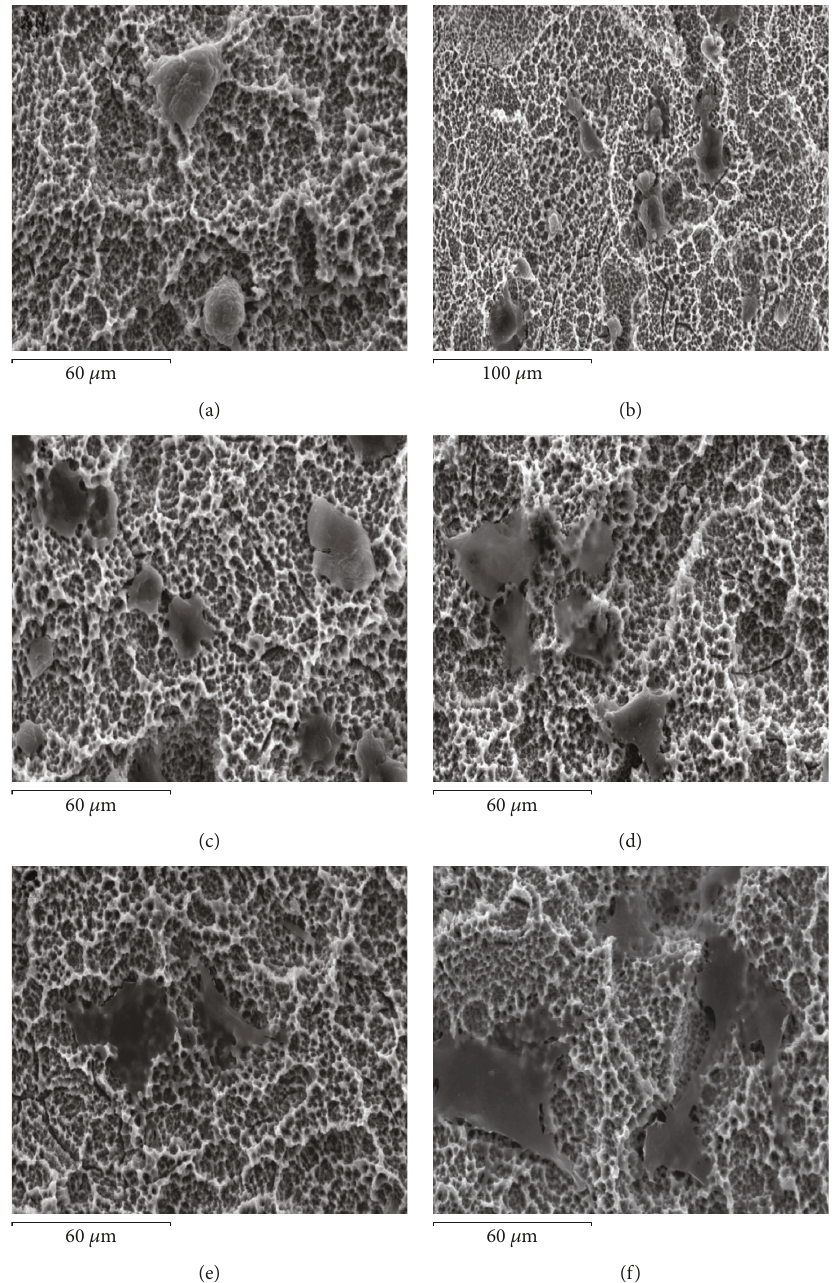
Figure 4: Morphological adaptation of MSCs on the modSLA Ti surface. MSCs exhibited similar morphological adaptations as when seeded on the SLA. (a – c) MSCs appeared very rounded at 5, 15, and 30 min post seeding. (d) MSCs displayed extensions emanating across the surface by 60 min and had (e) begun exhibiting a stretched asymmetric form by 3 h that continually progressed till 24 h